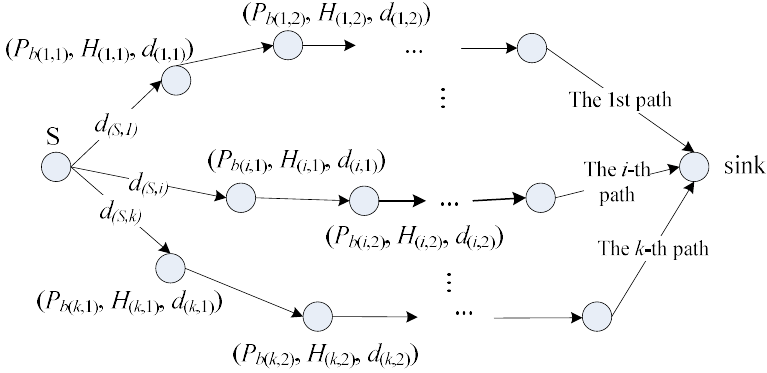
Figure 3. Packet delivery over k disjointed paths.